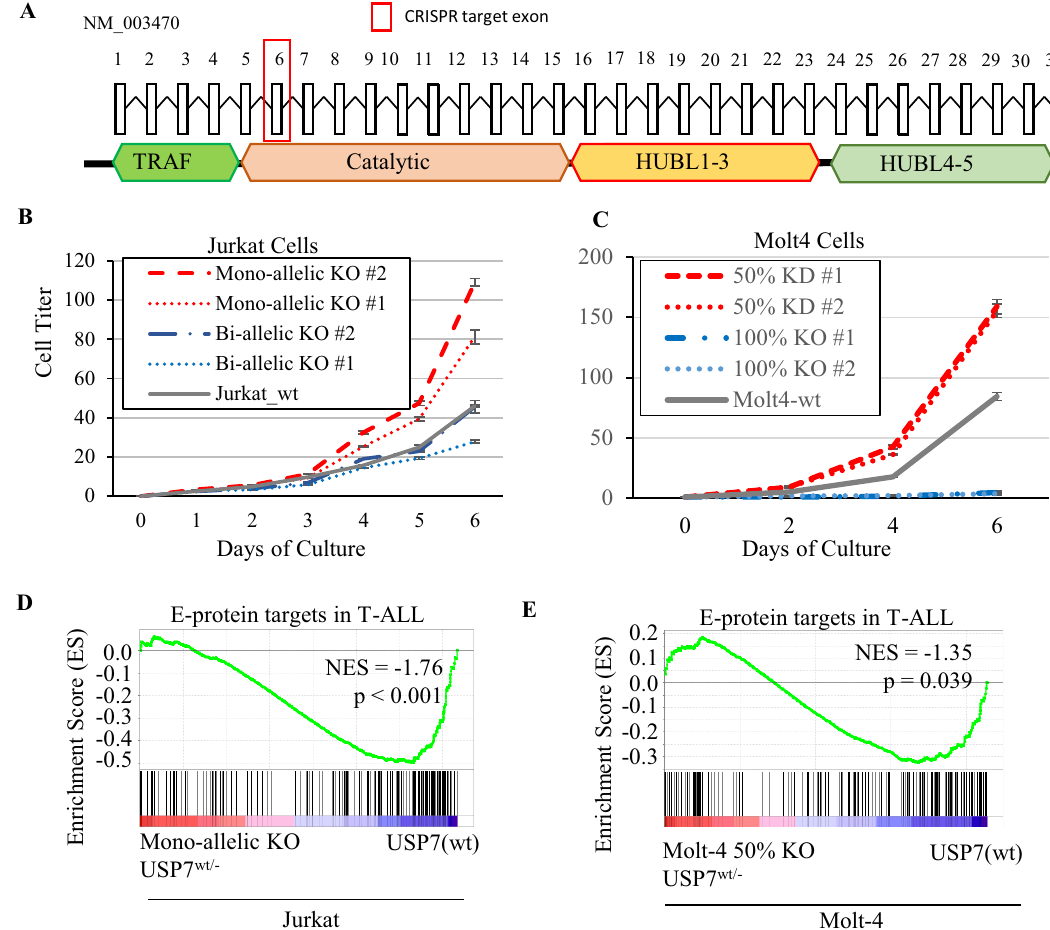
Figure 5. USP7 haploinsufficiency uniquely promotes cellular growth in Jurkat and Molt-4 cell lines. ( A ) USP7 haploinsufficiency generated by CRISPR genome editing targeting USP7’s exon 6. ( B ) ATP monitoring system cellular growth assay for the USP7 homozygous KO, USP7 heterozygous KO, and USP7 wild-type control in Jurkat cells. ( C ) Cellular growth assay of the wild-type and CRISPR clones in Molt-4. ( D ) GSEA analysis showing that genes down-regulated in the USP7-heterozygous-KO Jurkat cells compared to USP7-wt control are enriched for E-protein targets negatively regulated by TAL1. ( E ) GSEA analysis showing that genes down- regulated in the USP7 50% KD Molt-4 cells compared to wild-type are enriched for E-protein targets negatively regulated by